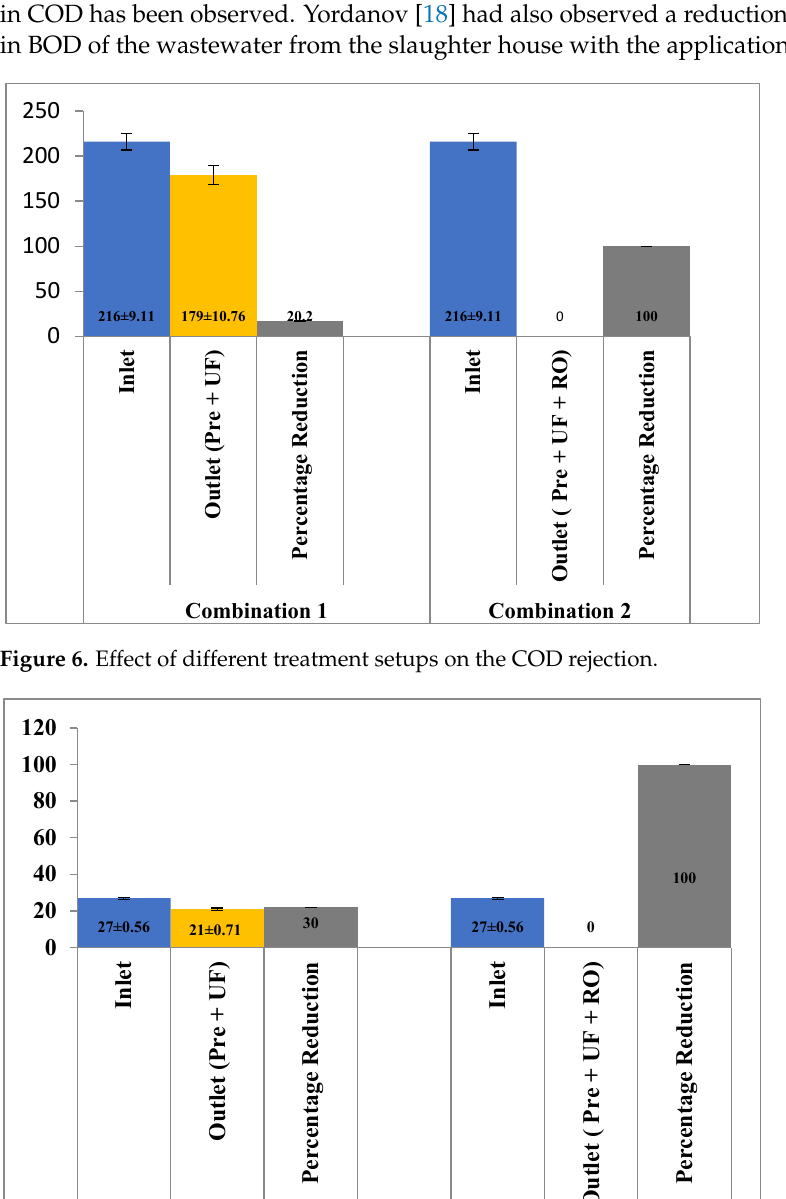
Figure 5. Effect of different treatment setups on the TDS rejection . In terms of COD and BOD, the reduction potential using pre-filtration and UF was 17.12% (216 ± 9.11 mg/L to 179 ± 10.76 mg/L) and 22% (27 ± 0.56 mg/L to 21 ± 0.71 mg/L), respectively. However, the addition of the RO membrane along with pre-filtration and UF appeared to reduce 100% of COD and BOD from the effluent (Figures 6 and 7). These results are in agreement with the study conducted by [20] on phenolic wastewater generated from a paper mill and with the application of a combination of UF-NF/RO a reduction of 95.5% in COD has been observed. Yordanov [18] had also observed a reduction of more than 94% in BOD of the wastewater from the slaughter house with the application of ultra-filtration.